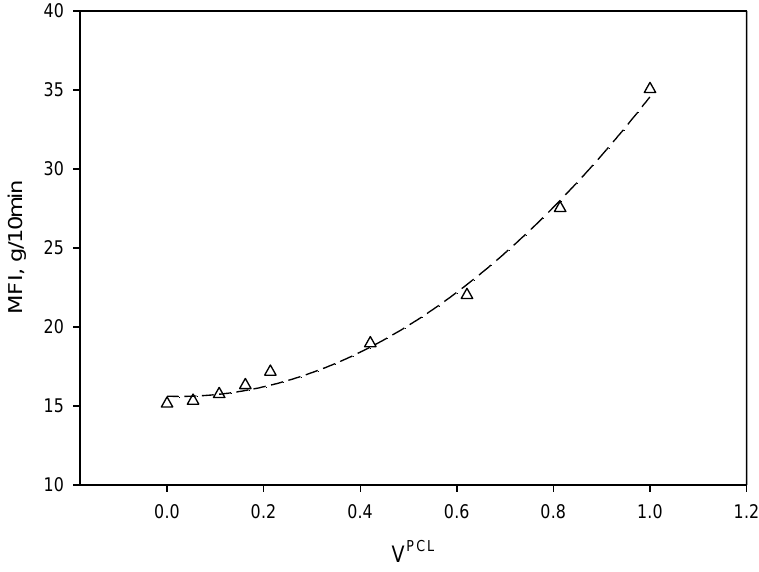
Figure 1. Evolution of melt flow index (MFI) as the amount of PCL was increased. Dashed line corresponds to a second order polynomial regression.